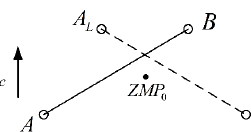
Figure 21. Position of 𝑍𝑀𝑃 0 and the support lines